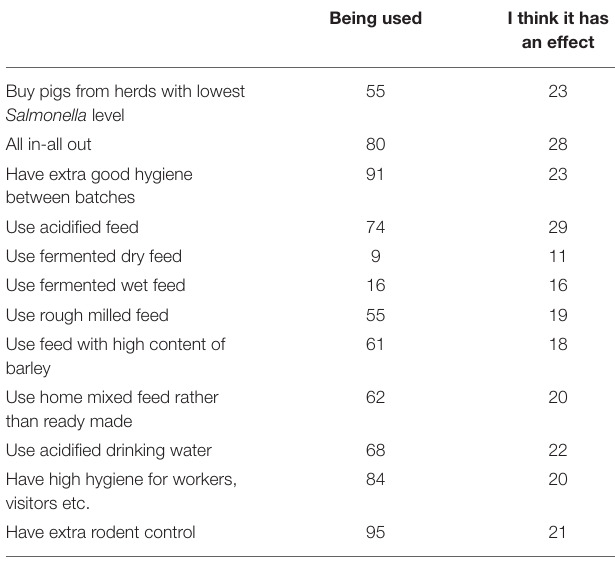
TABLE 5 | Industry cost estimates for applying on farm actions to reduce Salmonella prevalence and penalties for Salmonella prevalence (per finisher pig). Action